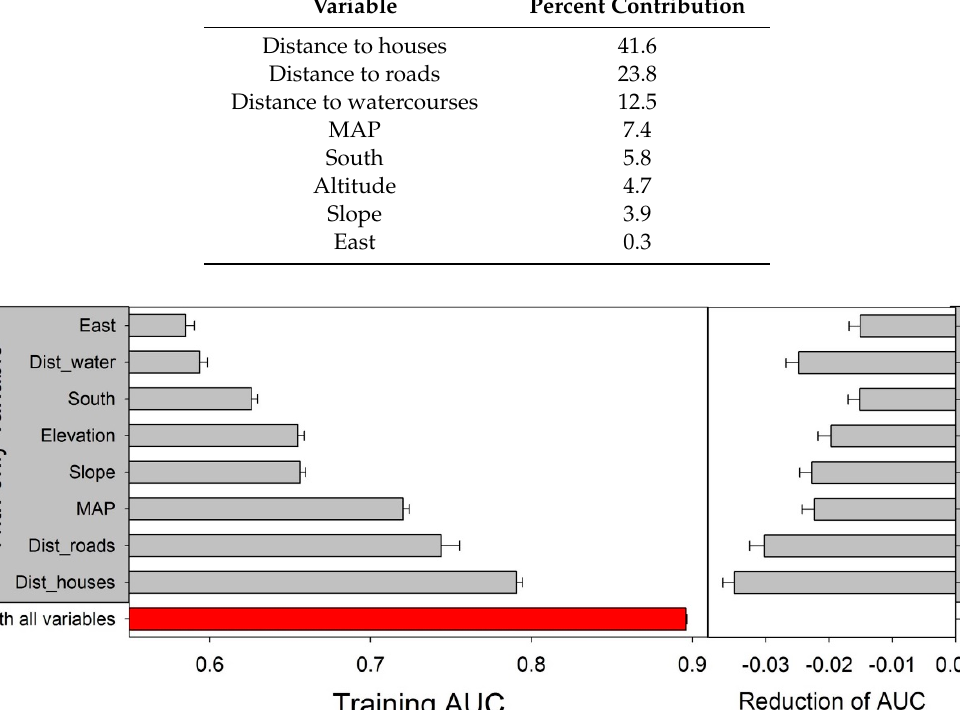
Figure 2. Area under the receiver operating characteristic curve (AUC) for the complete model (red bar) and for univariate models (bars on the left), and the reduction in AUC for the complete models excluding one variable (bars on the right). MAP: mean annual precipitation; South: relative south aspect; East: relative east aspect.